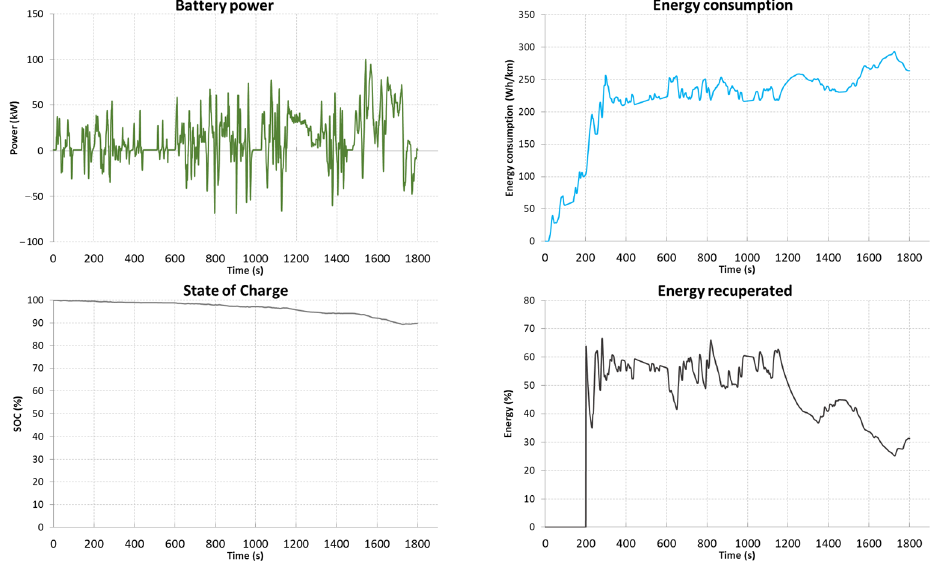
Figure 14. WLTP results of simulation tests for the 4 × 4 drive system with Type 2 energy storage.